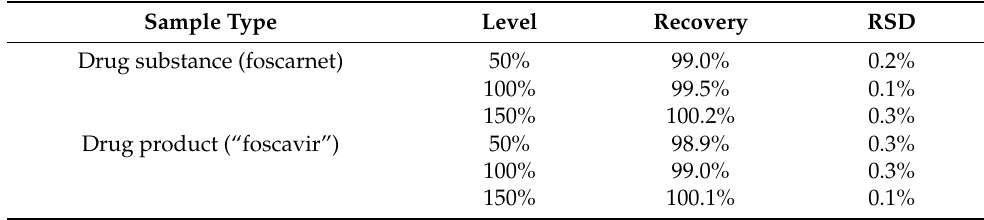
Table 7. Recovery and repeatability of foscarnet in different samples at different